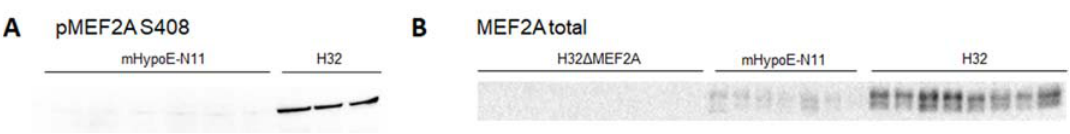
Figure A2. ( A ) Cell viability in H32 vs. H32 Δ MEF2A. n = 24 per group. ( B ) Cell viability in OT ‐ treated mHypoE ‐ N11 cells. n = 22–24 per group.